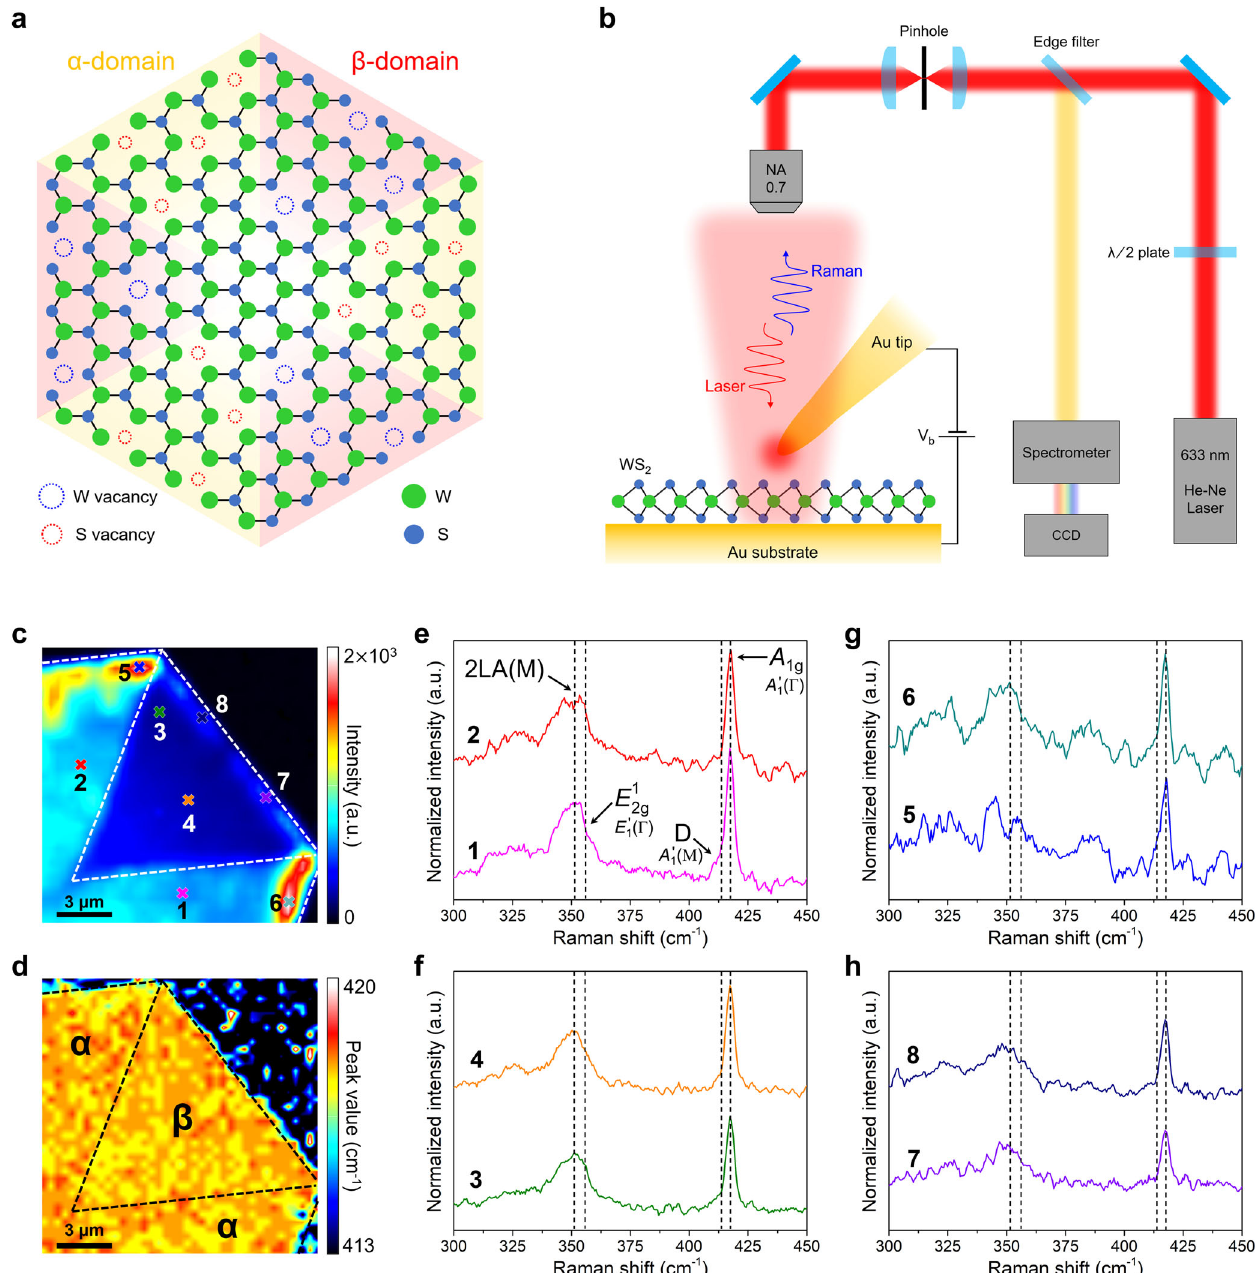
Fig. 1 Raman scattering for monolayer WS 2 . a Schematic of single-crystalline hexagonal WS 2 monolayer. b Schematic of STM-based TERS system with a gap-mode con fi guration. STM-TERS measurements were performed at a constant-current mode by applying a bias voltage of 50 mV to the sample. c Confocal Raman map of A 1g peak area intensity with PL background (acquisition time per point: 1 s). d Distribution image of A 1g peak from the Raman map in ( c ). The white and black dashed lines in c and d indicate the domain boundaries and edges of WS 2 . Confocal Raman spectra from e α -domain, f β -domain, g edge of α -domain, and h edge of β -domain. The spectra were extracted from each colored cross in ( c